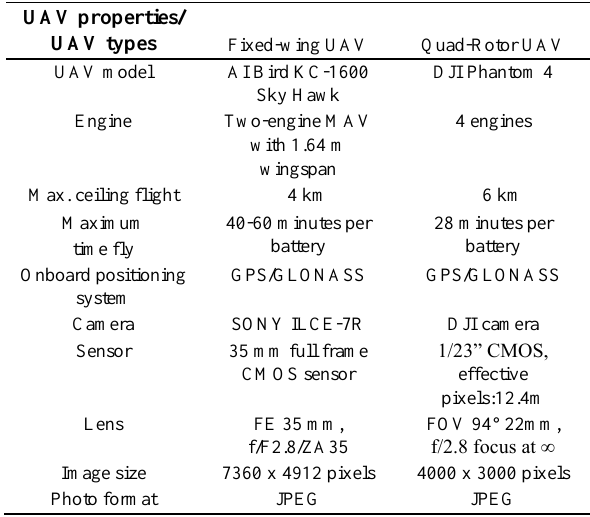
Figure 3. The experiment design of fix-wing